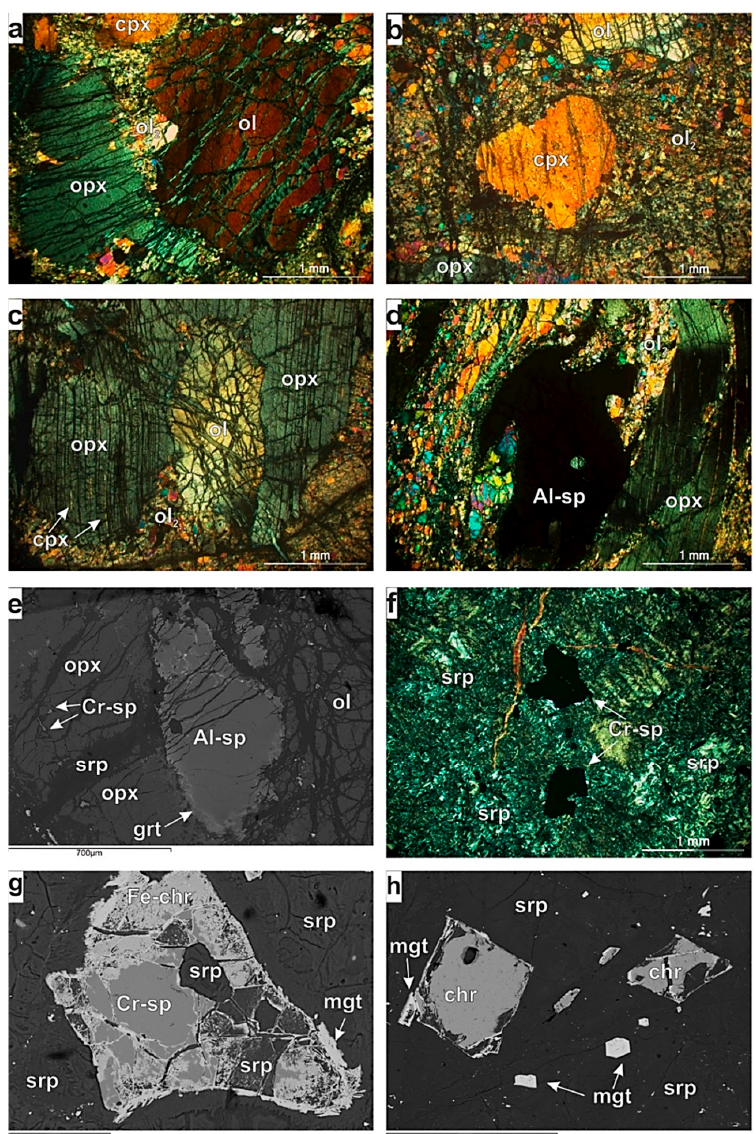
Figure 4. Textural characteristics of ultramafic rocks from Edessa ophiolite: ( a ) Photomicrograph of porphyroclastic texture in a lherzolite, showing porphyroclasts of orthopyroxene (opx) olivine (ol) and clinopyroxene (cpx) surrounded and partially replaced by neoblastic olivine (ol 2 ) (sample ED.88, + Nicols); ( b ) Photomicrograph of strained clinopyroxene (cpx), olivine (ol) and orthopyroxene (opx) porphyroclasts in a lherzolite surrounded by neoblastic olivine (ol 2 ) (sample ED.86, + Nicols); ( c ) Photomicrograph of an orthopyroxene (opx) porphyroclast with exsolution lamellae of clinopyroxene (cpx) replaced and surrounded by olivine neoblasts (ol 2 ) in a lherzolite (sample ED.86, + Nicols); ( d ) Photomicrograph of anhedral Al-spinel (Al-sp) with lobate boundaries and bended orthopyroxene porphyroclast (opx) surrounded by olivine neoblasts (ol 2 ) in a lherzolite (sample ED.87, + Nicols); ( e ) Back-scattered electron image of anhedral Al-spinel (Al-sp) rimmed by garnet (grt), and surrounded by olivine (ol) and orthopyroxene (opx) porphyroclasts in a lherzolite. Secondary Cr-spinel (Cr-sp) is developed along the cleavage of partially serpentinised (srp) opx (sample ED.89); ( f ) Photomicrograph of interlocking and hourglass serpentine (srp) and anhedral Cr-spinel (Cr-sp) in a serpentinised harzburgite (sample ED.28.1, + Nicols); ( g ) Back-scattered electron image of Cr-spinel (Cr-sp) with curved boundaries and thick rims of ferritchromit (Fe-chr) and magnetite (mgt) in a serpentinised harzburgite (sample ED.28.2); ( h ) Back-scattered electron image of euhedral chromite (chr) with thin rims of magnetite (mgt) in serpentinised matrix (sample ED.115).